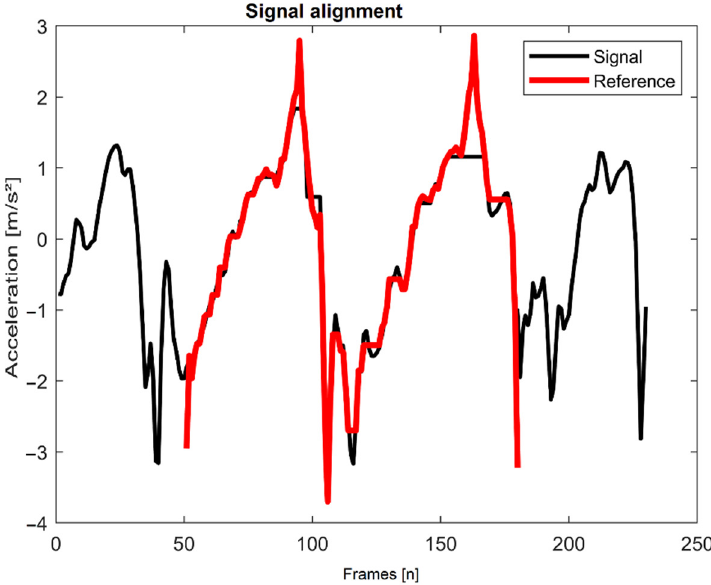
Figure 4. Visualization of the DTW alignment of the walking reference snippet to an input signal.